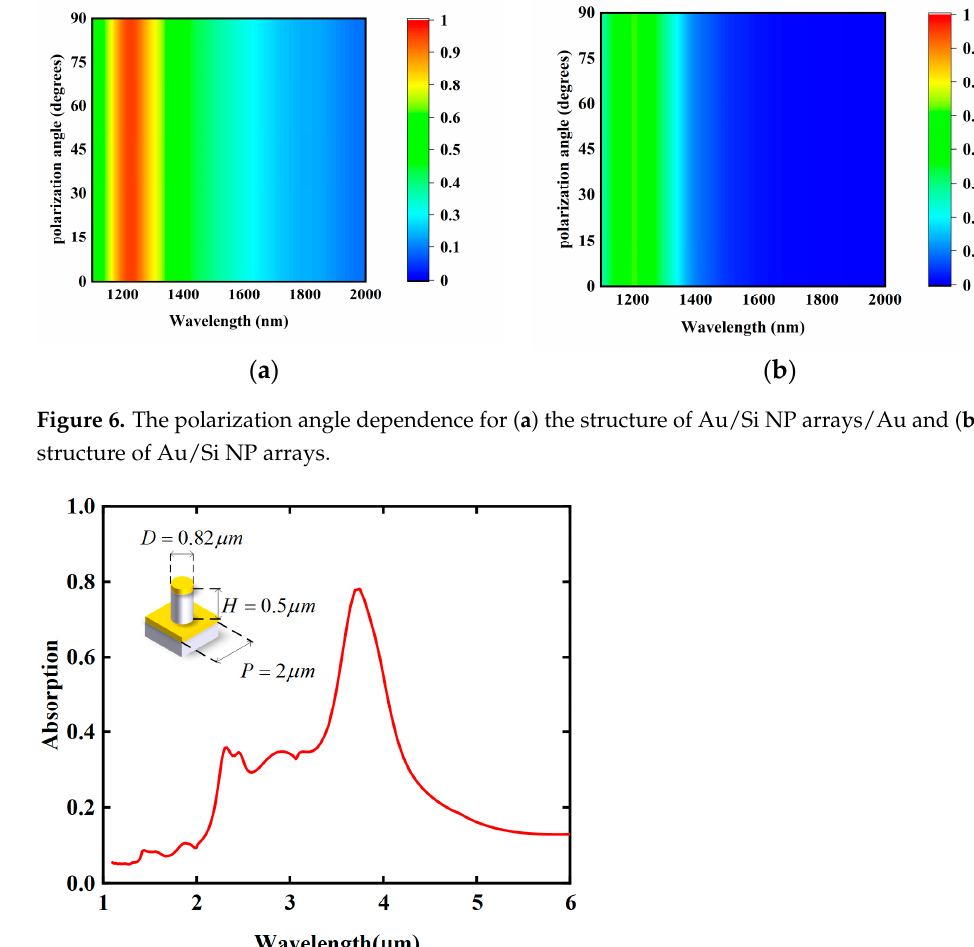
Figure 6. The polarization angle dependence for ( a ) the structure of Au/Si NP arrays/Au and ( b ) the structure of Au/Si NP arrays.